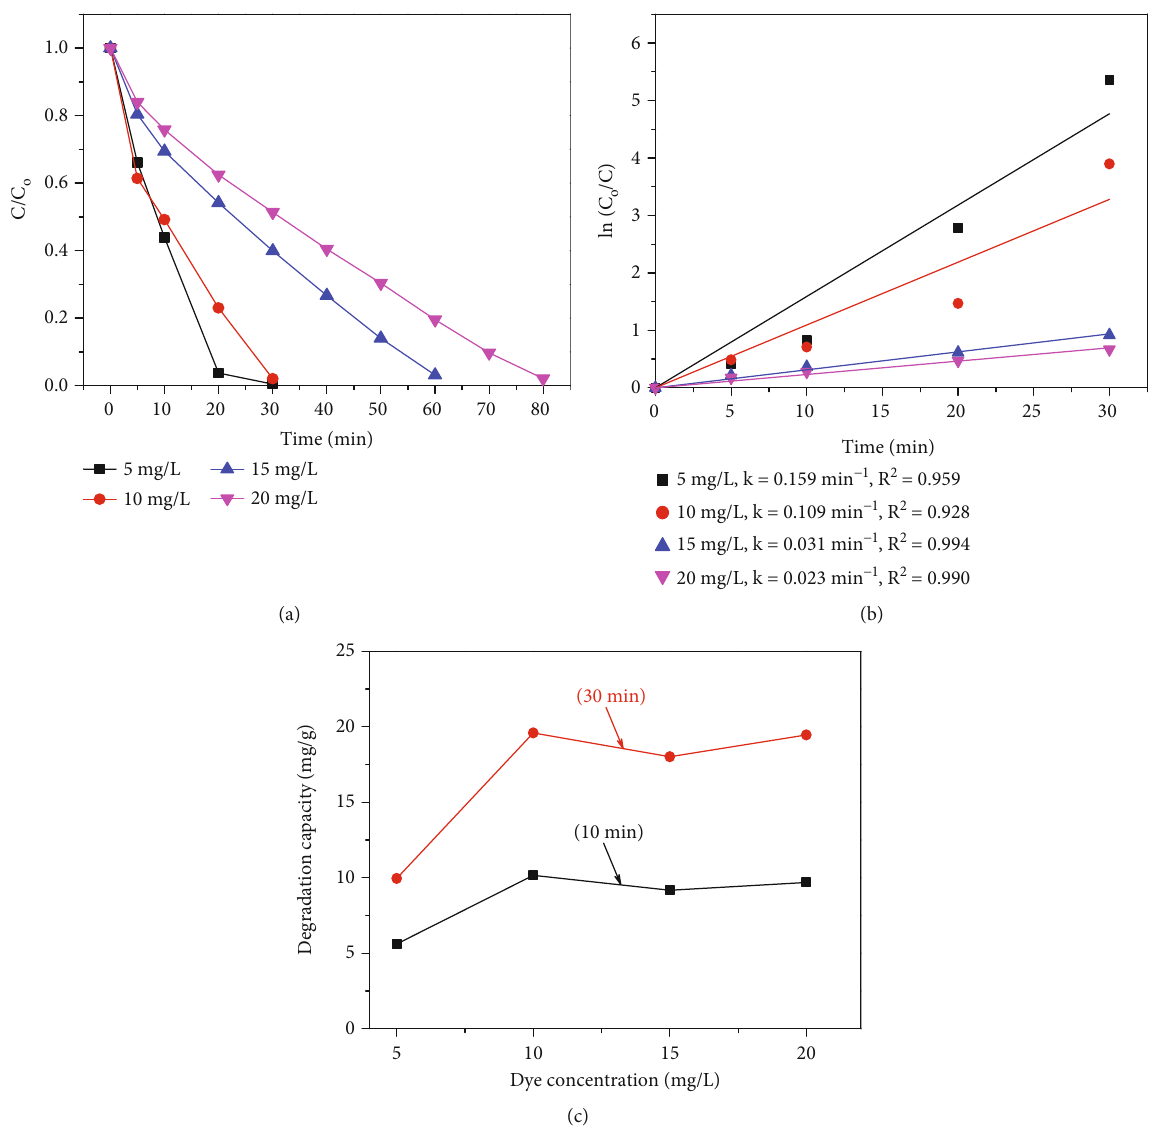
Figure 10: (a) E ff ect of initial TA concentration of TA on photodegradation, (b) the kinetic curves, and (c) the DC with di ff erent initial concentrations: the reaction conditions: catalyst dosage of 0.5 g/L, pH solution of 6.0, and Hg lamp 250